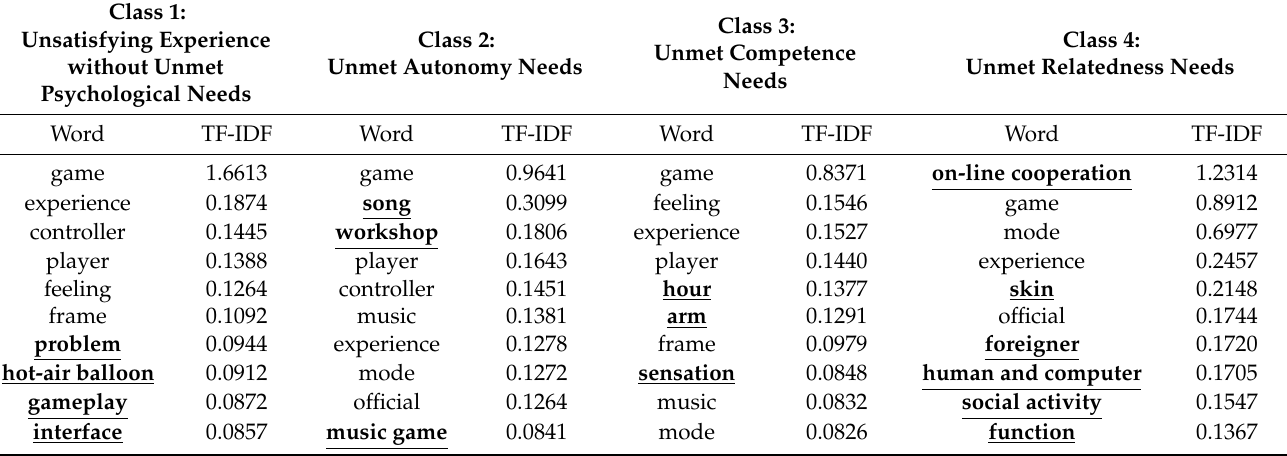
Table 5. Keywords of sentences related to the unsatisfying experience.